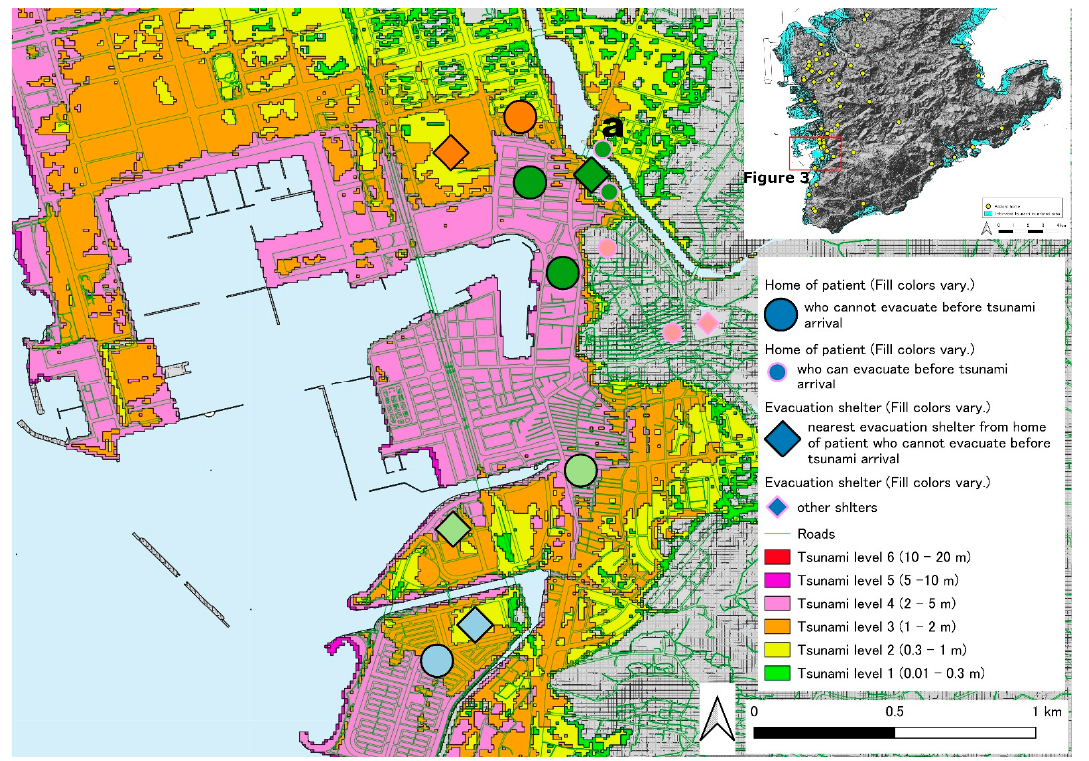
Figure 3. The locations of patients with chronic respiratory diseases with HOT who live in the tsunami inundation areas on the western coast of the southern part of the main island of Okinawa-1.